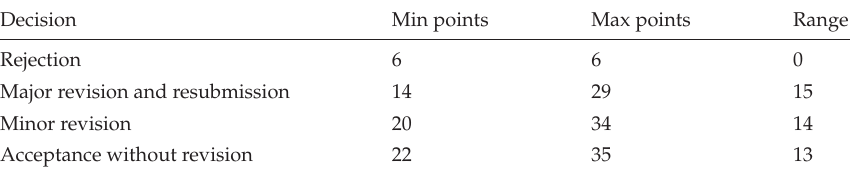
Table 19: Overlapping points and decisions for PR2.